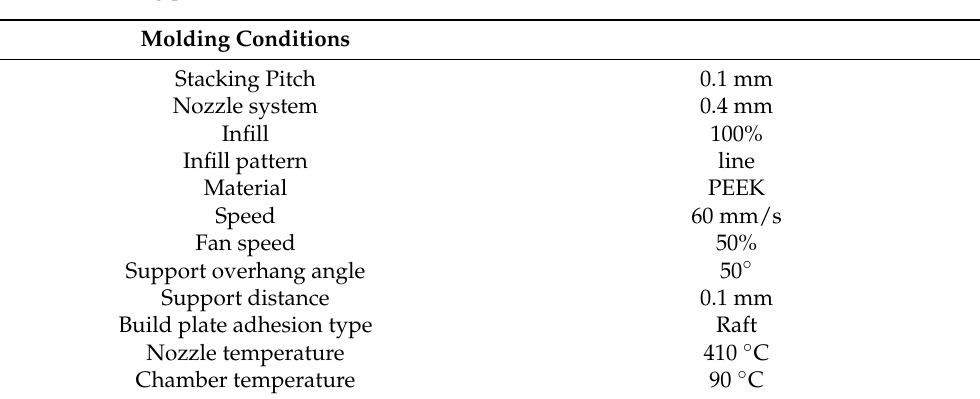
Table 2. Printing